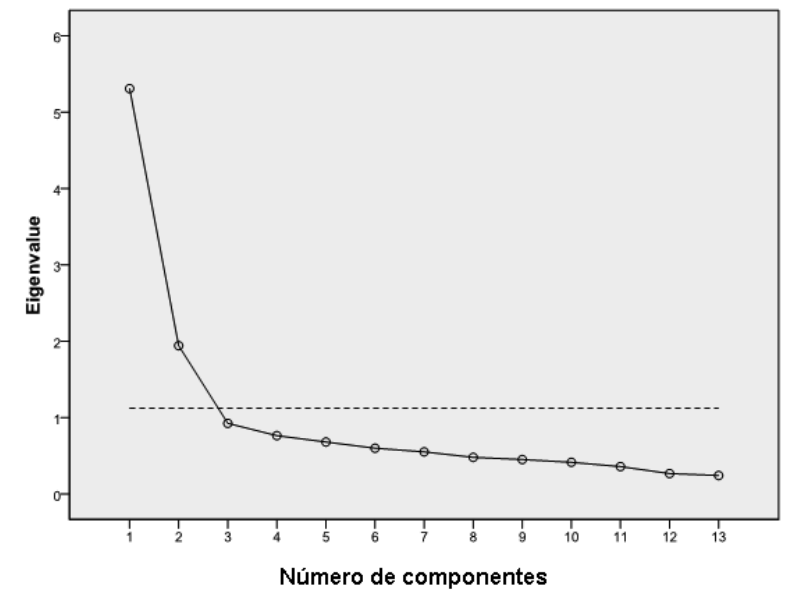
Figura 3 . Gráfi co de sedimentação gerado pela análise de componentes principais dos dados